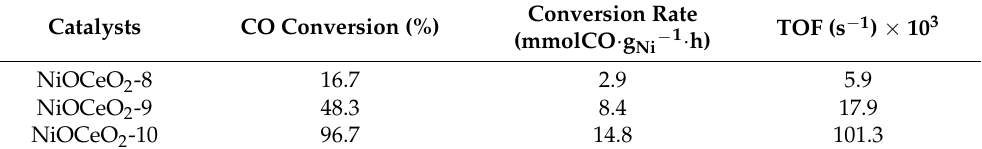
Table 3. Catalytic results at 220 °C.